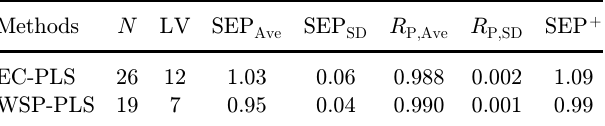
Table 2. Prediction e®ects of the optimal EC-PLS and WSP- PLS models in